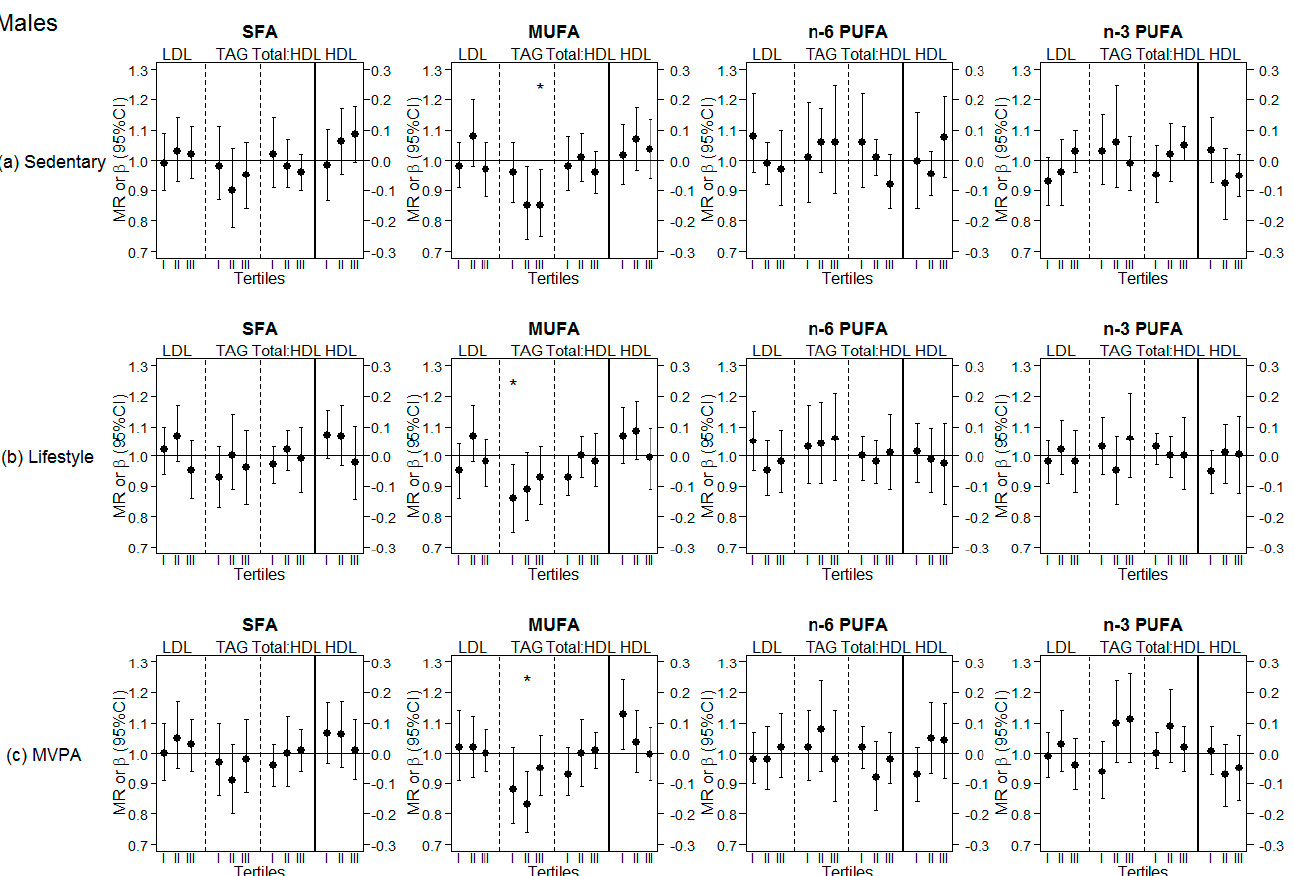
Figure 3. Analyses stratified by tertiles of different physical activity (PA) levels in males. ( a ) Sedentary: Top row, analyses stratified by tertiles of sedentary behavior; ( b ) Lifestyle: Middle row, analyses stratified by tertiles of lifestyle PA; ( c ) MVPA: Bottom row, analyses stratified by tertiles of moderate-to-vigorous PA (MVPA); LDL: Low-density lipoprotein cholesterol; HDL: High-density lipoprotein cholesterol; TAG: Triglycerides; Total:HDL: Total to HDL cholesterol ratio; SFA: Saturated fatty acids; MUFA: Monounsaturated fatty acids; PUFA: Polyunsaturated fatty acids; MR: Means ratio (for effects on LDL cholesterol, TAG and Total:HDL, on left side of continuous black line); β : Beta coefficient (for effects on HDL cholesterol, on right side of continuous black line); * significant associations following Bonferroni correction for multiple testing ( p -value < 0.017). Tertiles (I, II, III): Tertiles of the respective physical activity level (Sedentary, Lifestyle PA, MVPA).